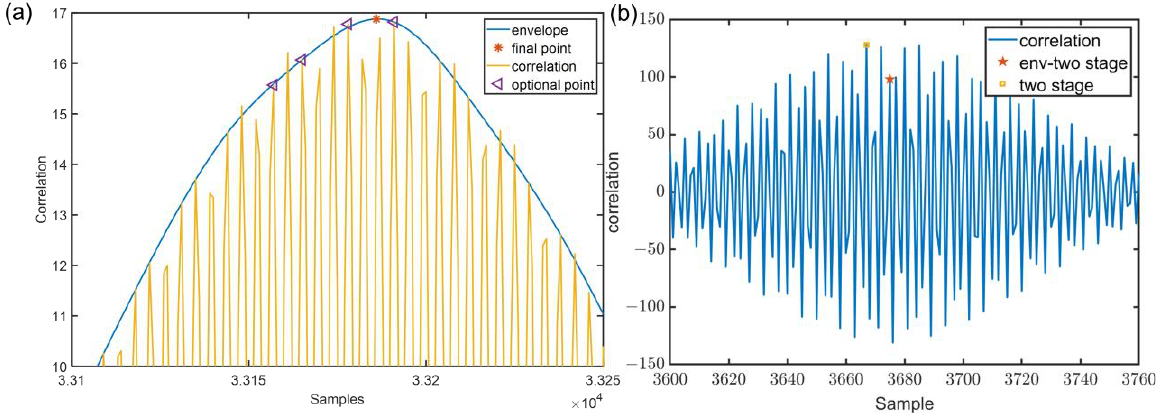
Figure 14. ( a ) Example of env-two-stage. ( b ) The comparison between two-stage and env-two-stage.